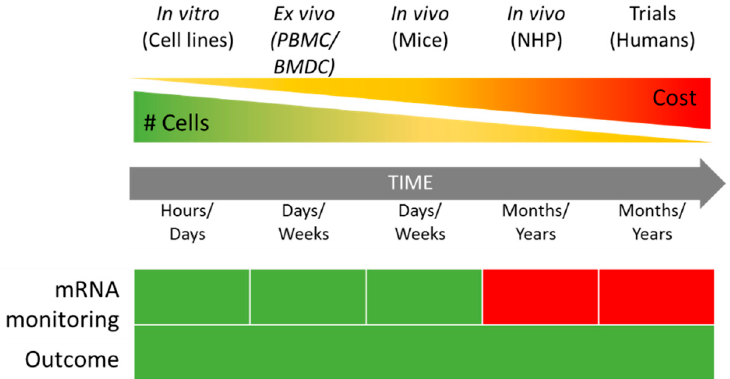
Figure 2. Comparison between in vitro, ex vivo, and in vivo approaches to mRNA vaccine evaluation in terms of cost and time. mRNA monitoring: Green—mRNA transfection and translation can be monitored by flow cytometry and western blotting. Red—no easy tracking possible. #—Number of cells available. PBMC—Peripheral Blood Monocytes Cells, BMDC—Bone-Marrow Derived Cells, NHP—Non-human Primates.